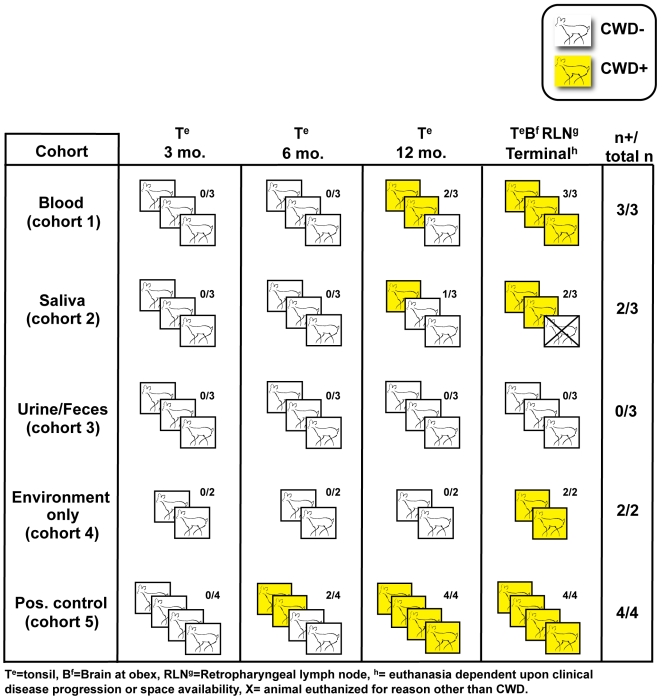
PrPCWD detection by longitudinal tonsil biopsy and terminal necropsy.